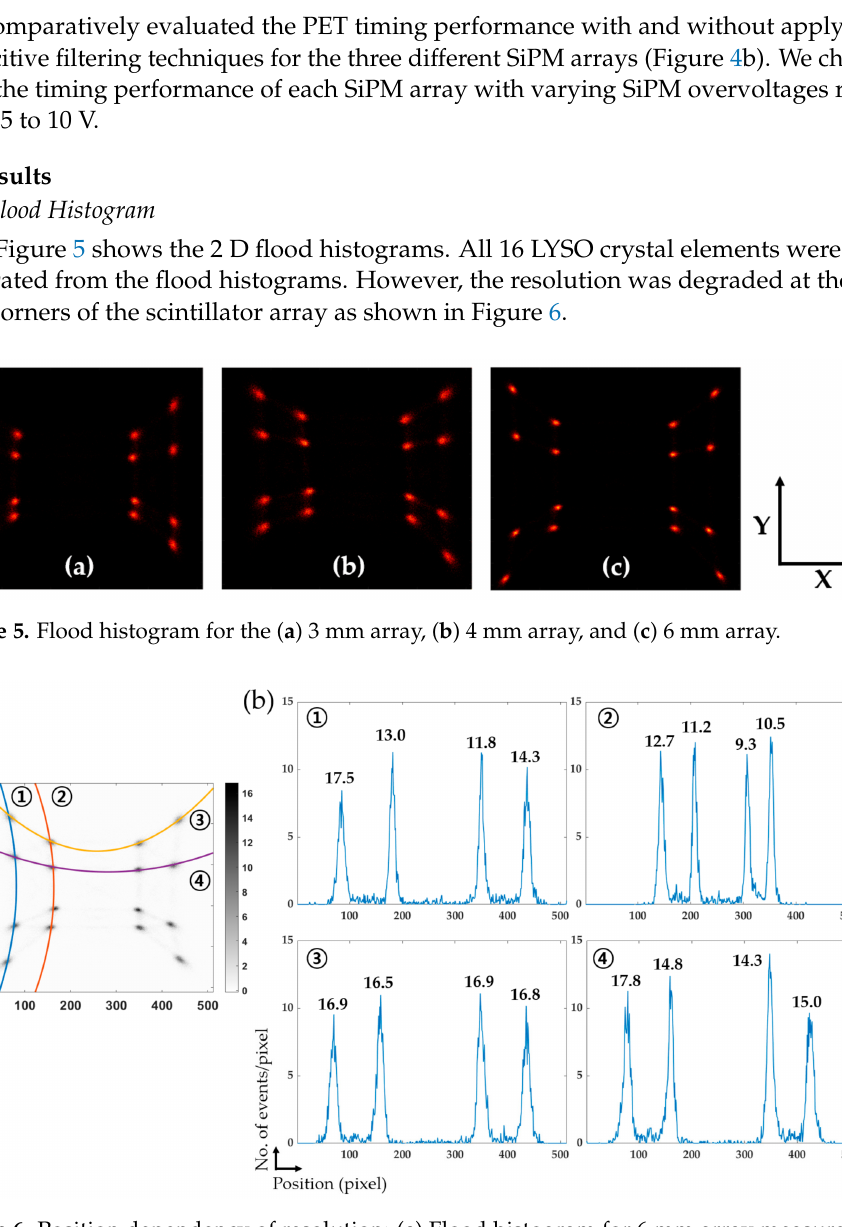
Figure 6. Position dependency of resolution: ( a ) Flood histogram for 6 mm array measured using overvoltage yielding the best timing resolution and ( b ) horizontal and vertical projection histograms and FWHM (pixel) of peak distributions of projection